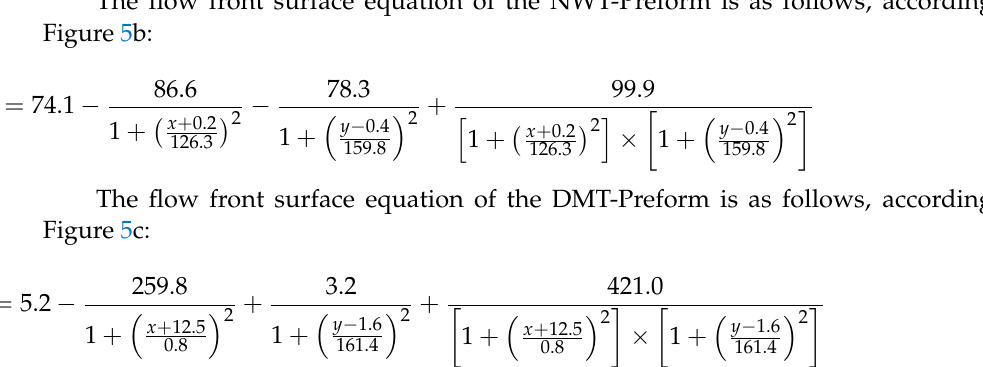
Figure 5. Fitted flow front of resin in the preforms. ( a ) NT-Preform [17]; ( b ) NWT-Preform; ( c ) DMT-Preform.